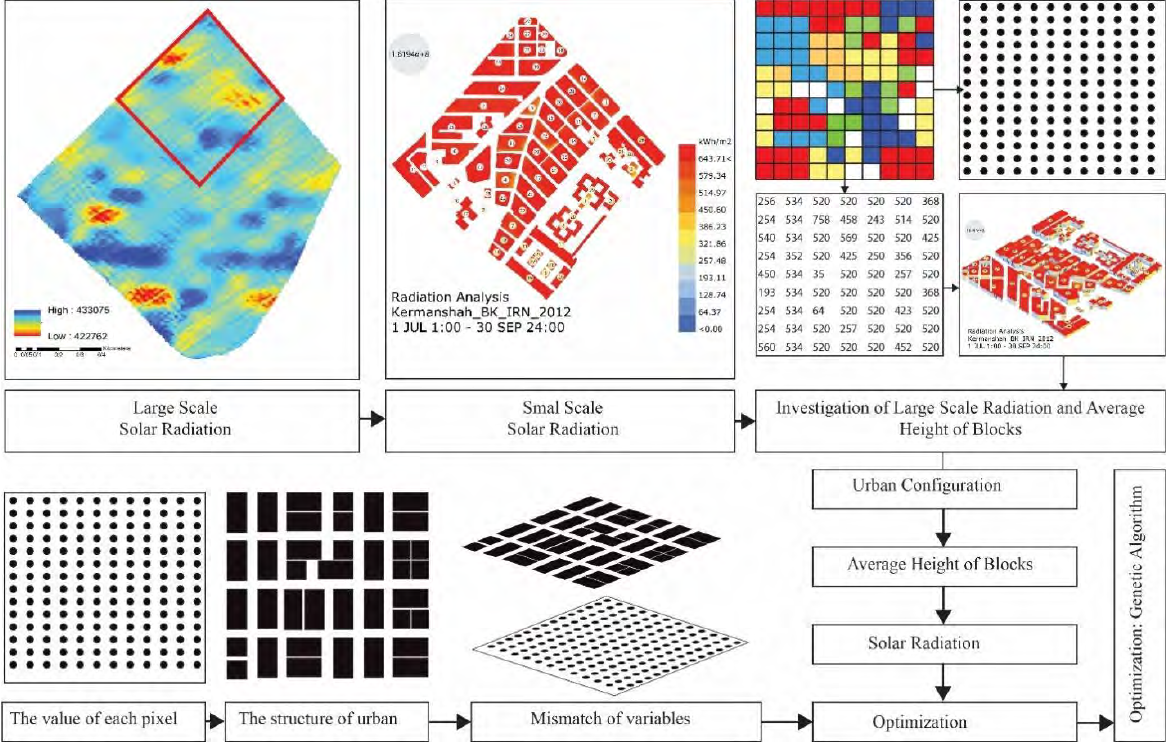
Figure 19: Evaluation of the compatibility of macro data at the satellite level and optimized data based on genetic algorithm Based on analyses, simultaneous and intelligent use of satellite data in the initial development patterns and matching of height codes with such patterns can help determine the maximum radiation in the urban context. On the other hand, this study shows the need to develop intelligent algorithms based on machine learning algorithms and optimization algorithms in the future. The use of tools and algorithms on this basis can be helpful in the smart development of cities to receive maximum solar radiation and adapt the urban form to other climatic